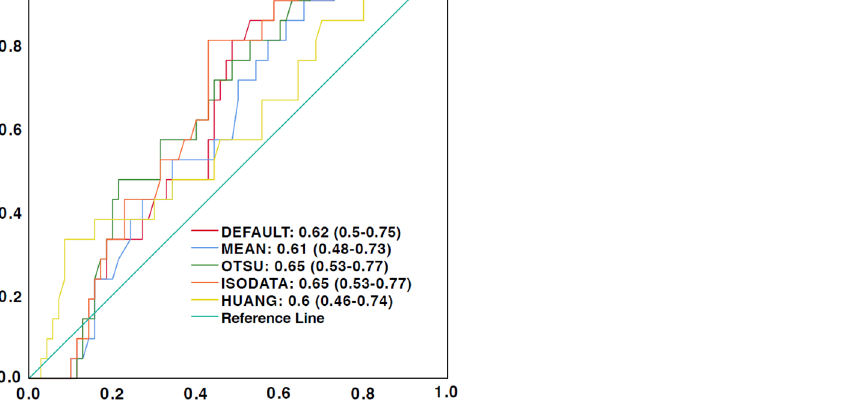
Figure 5. Receiver operating characteristics (ROC) curves for discrimination of diseased eyes from the healthy control group in the choriocapillaris slabs. The caption shows the area under the curve (AUC) values and the 95% confidence interval.